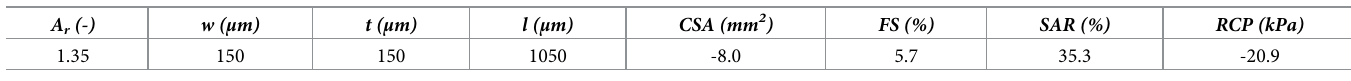
Table 3. Baseline stent design parameters ( A r , w , t , and l ) and its respective performance metrics ( CSA , FS , SAR , and RCP ). A r (-) w